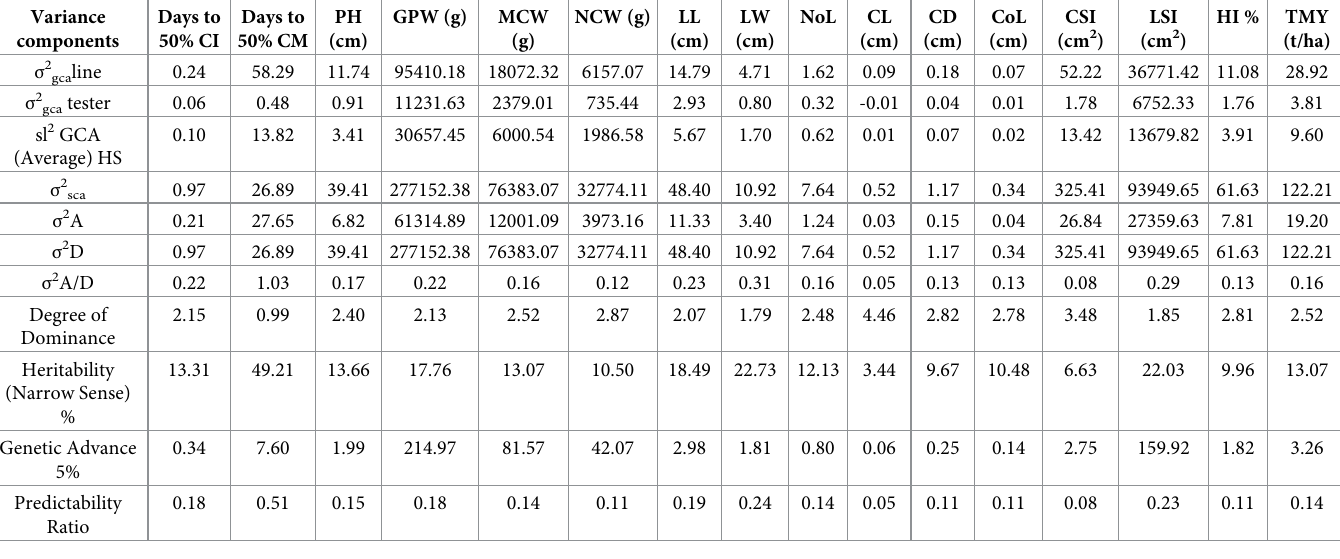
Table 3. Estimates of genetic components of variance, heritability, genetic advance and predictability ratio for sixteen vegetative and commercial traits. Variance Days to Days to components 50% CI 50%